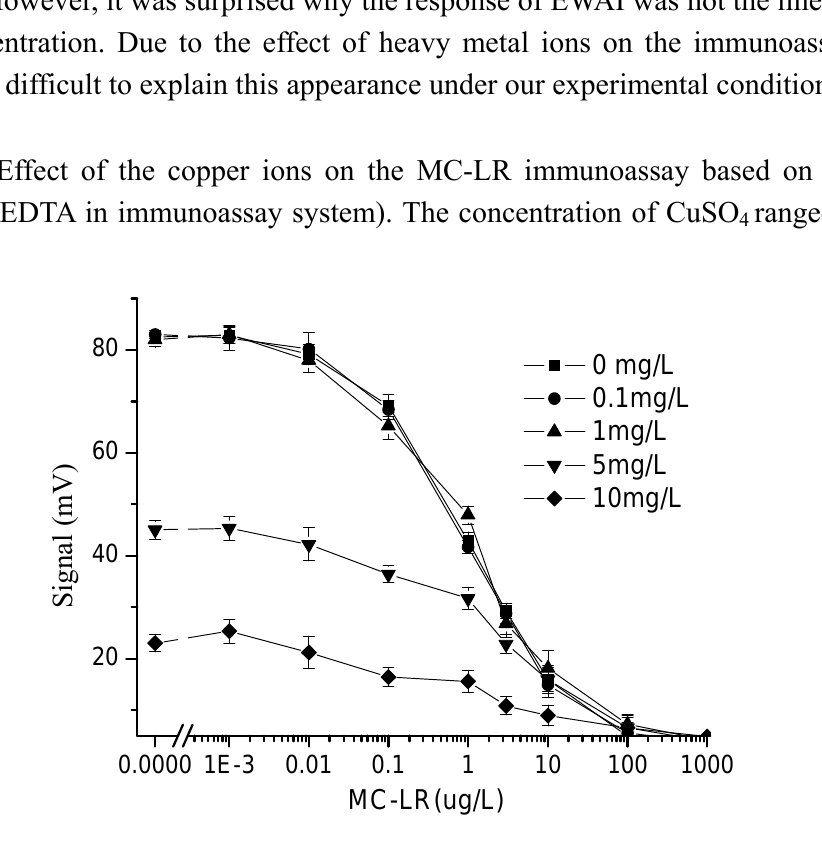
ranged from 0 to 4